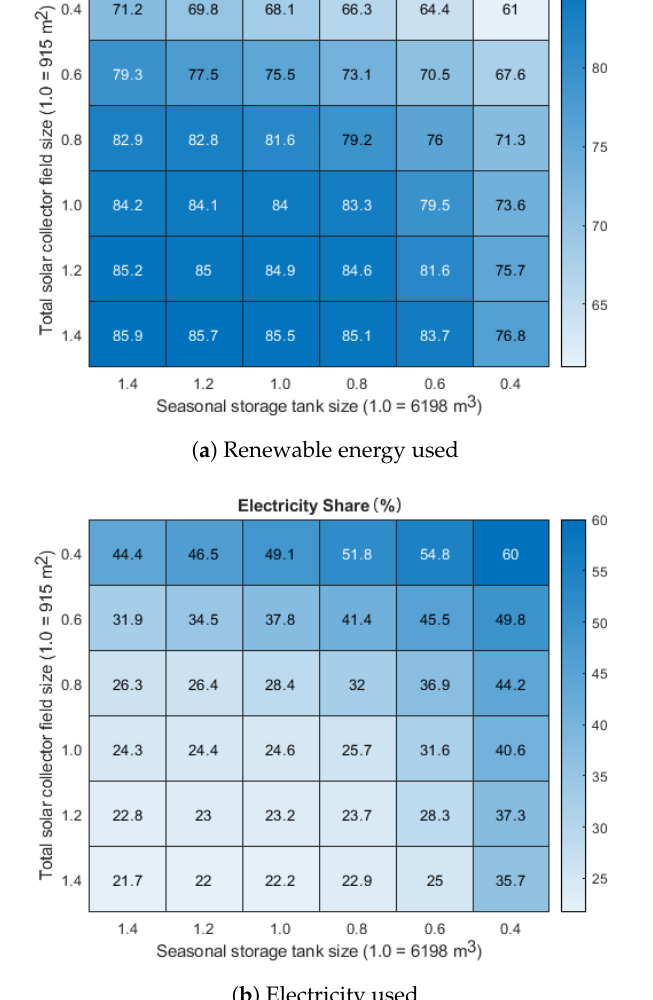
Figure A1. KPI for different sizes of solar collector field and seasonal storage